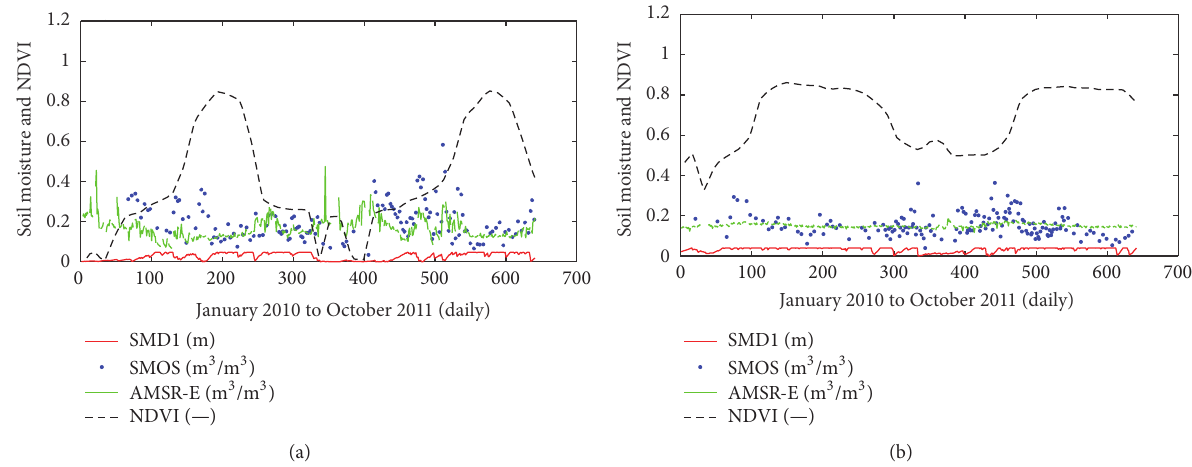
Figure 8: The time series plots of soil moisture products (SMOS and AMSR-E) and XAJ SMD1 with MODIS NDVI for the two selected basins: (a) PB and (b) FBB. The time step for soil moisture is Julian day and the one for NDVI is every 16 days.